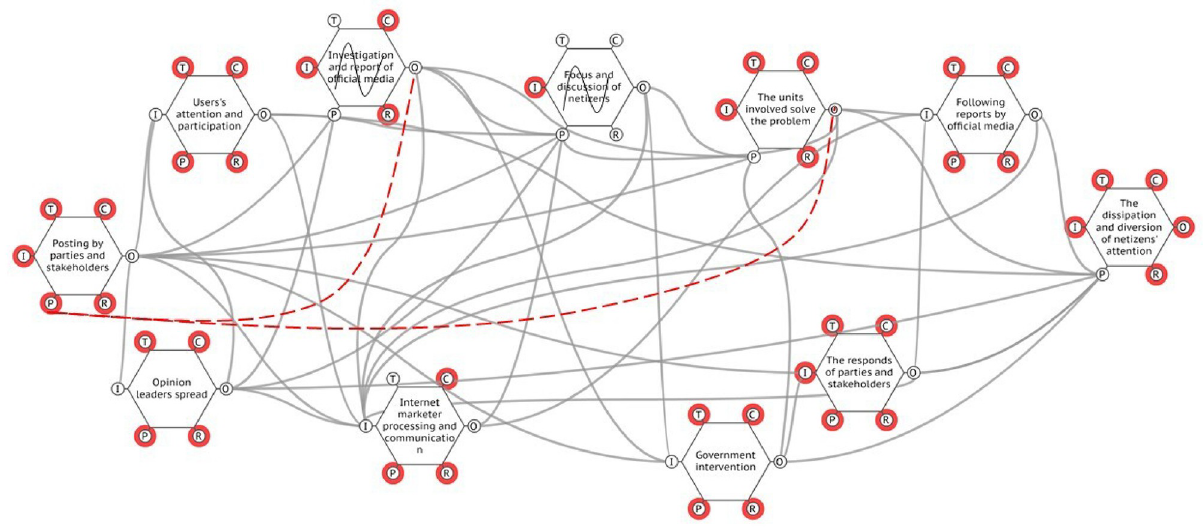
reflect the complexity and emergence of network public opinion, pay attention to the nodes that cause emotional resonance, and turn the focus of governance from content to emotion. Finally, we should integrate the background of digital humanities into it, and study the evolu- tion and governance system of public opinion with the combination of big data and theory.